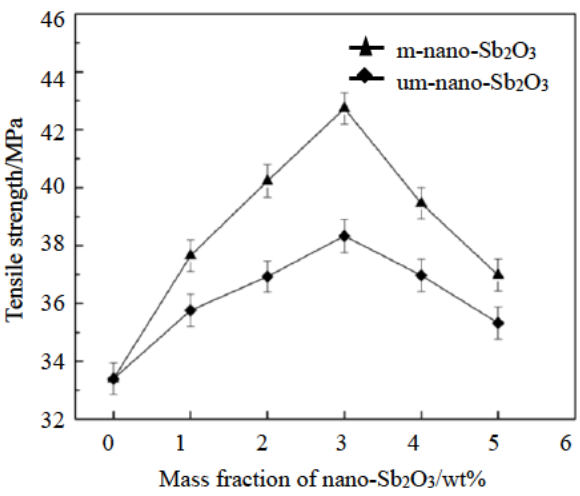
Figure 4: Relationship between tensile strength of the experimental materials and mass fraction of nano-Sb 2 O 3 particles